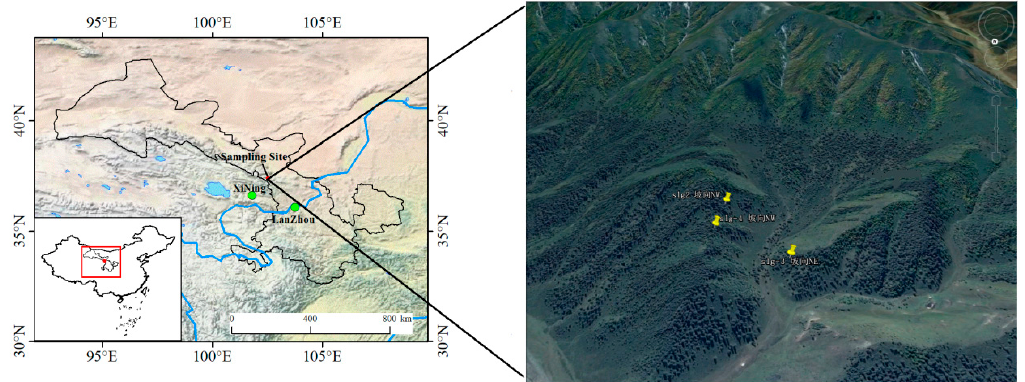
Figure 1. Geographic location of the collection sites (slg-2, slg-3, slg-4) of Picea crassifolia located in Shuanglonggou